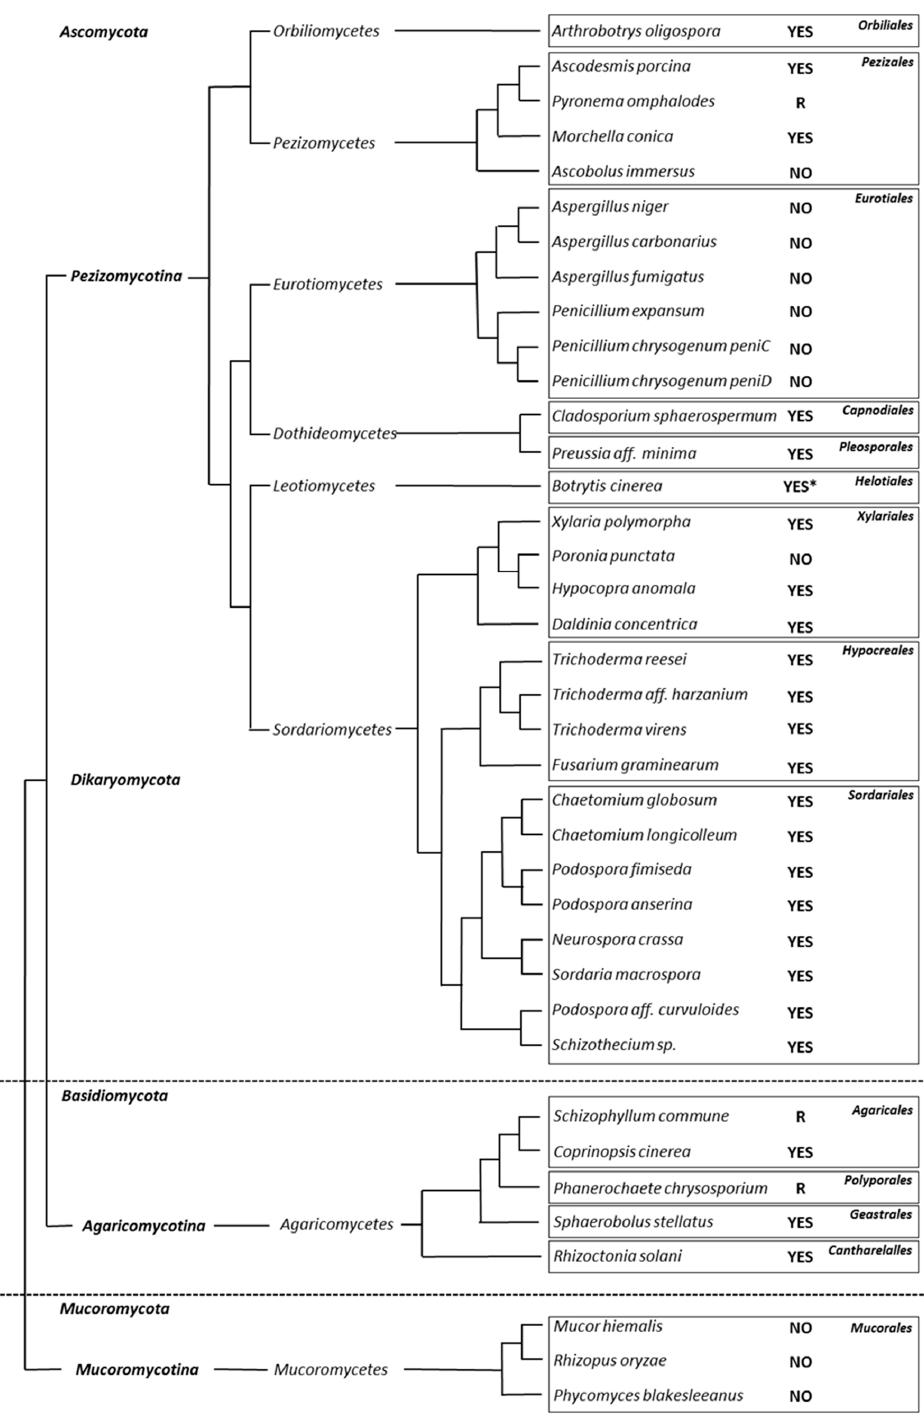
Figure 3. Phylogenetic tree of the 38 Eumycetes strains analyzed. “YES”, presence of appressoria; “R”, reorientation of hyphal growth towards cellophane; “NO”, no hyphal growth reorientation and no appressorium developed. This tree was built according to the “MycoCosm Fungal Tree of Life” of the JGI [22].